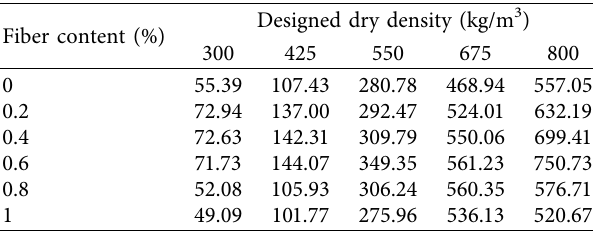
Table 8: Elastic modulus results of polypropylene fiber cast-in-situ foamed concrete (unit: